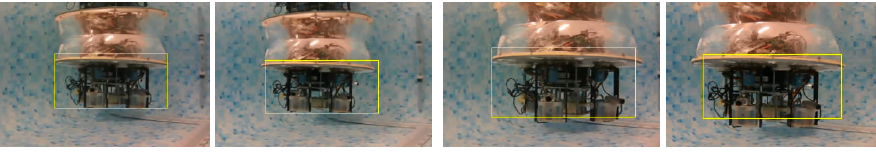
Figure 29. Images of second-level follower perspective and follower perspective of the three-robot “Round-up hunting” formation